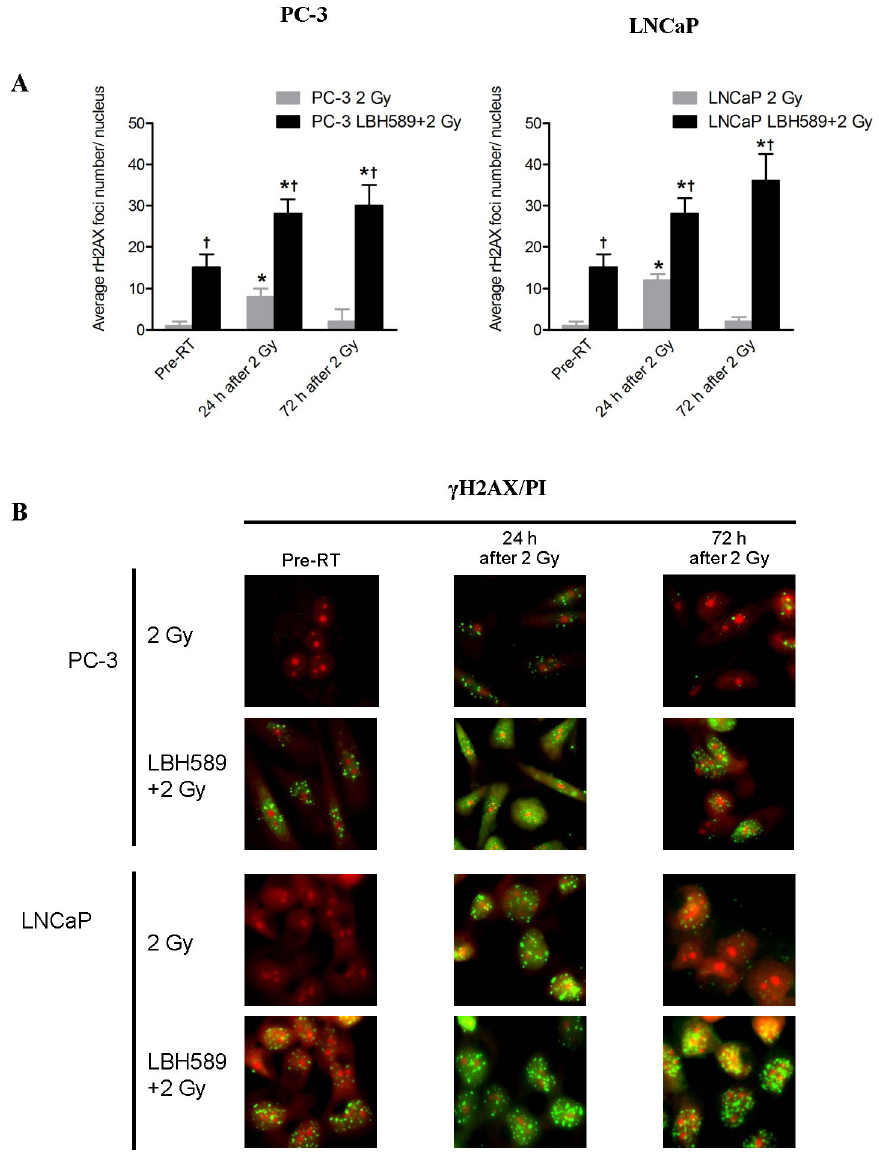
Figure 4. Quantitative analysis of DNA double strand break (DSB) marker γH2AX foci at pre-RT, 24 h and 72 h after 2 Gy RT or combination treatment in PC-3 and LNCaP cells. ( A ) After 2 Gy RT, average γH2AX foci number increased significantly at 24 h in both PC-3 and LNCaP cells and decreased to a lower level at 72 h while average γH2AX foci number in combination-treated (LBH589+2 Gy RT) cells was significantly higher than that in RT-treated cells at any time points and continued to increase until 72 h. ( B ) Representative images of γH2AX staining after 2 Gy RT or combination treatment (LBH589+2 Gy RT) in PC-3 and LNCaP cells. p <0.05(†) indicates significant difference between RT-treated cells and combination-treated cells at the same time point. p <0.05(*) indicates significant difference between cells at specific time points and cells receiving the same treatment at the “Pre-RT” time point. Points, mean; bars, SD. N=50. Typical images are shown from three independent experiments (N=3). Magnification × 60 in all images. doi: 10.1371/journal.pone.0074253.g004 LNCaP cells in the combination groups (Figure 3 ). The markers in nuclei was quantified as shown in Figures 5 - 7 . The BRCA-1, BRCA-2 and Rad-51 results from western blotting results from the western blot were consistent with the were further confirmed by immunofluorescence staining immunofluorescent staining results. Our findings suggest that in addition to affecting NHEJ repair pathway, LBH589 may also (Figures 5 - 7 ). Number of the foci from three protein repair